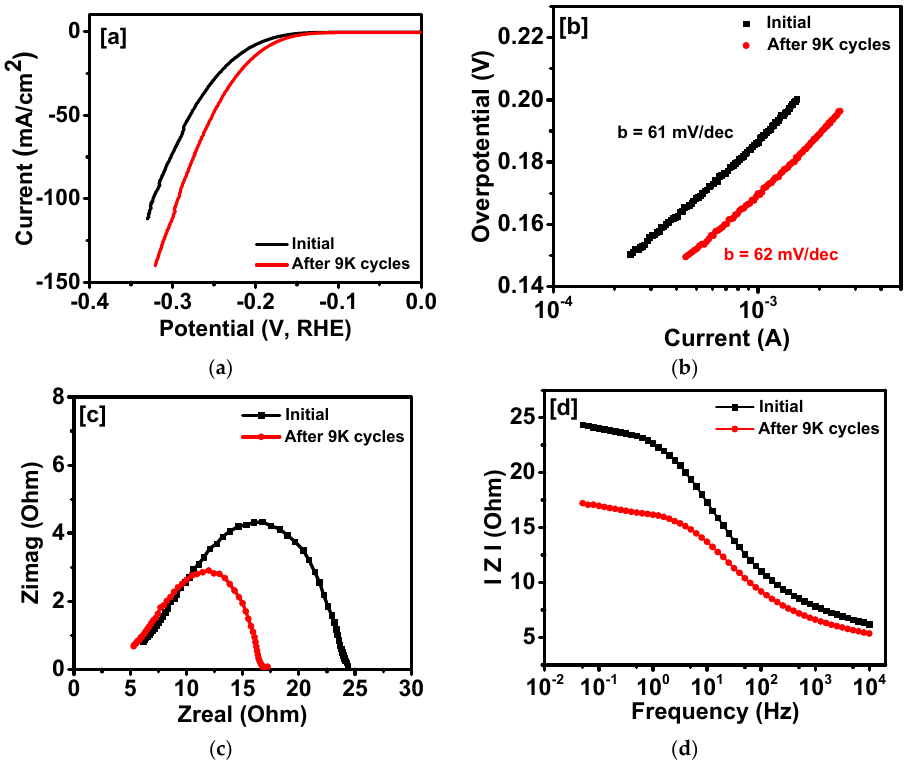
Figure 8. ( a ) Polarization curves; ( b ) corresponding Tafel slopes; ( c ) Nyquist plots; and ( d ) variation of impedance vs. frequency for a MoS 2 -CNFs sample before and after stability test (Electrochemical impedance spectroscopy (EIS) data are measured at − 0.45 V vs. Ag/AgCl).